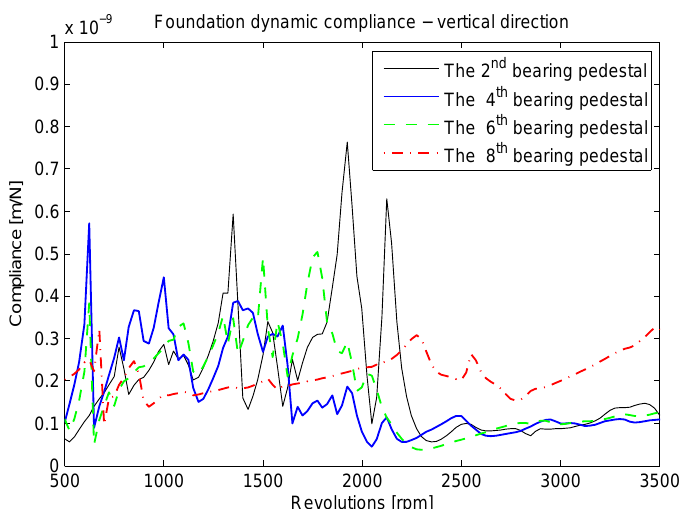
Figure 8. Modules of dynamic compliances of the chosen bearing pedestals used for model B in teh vertical